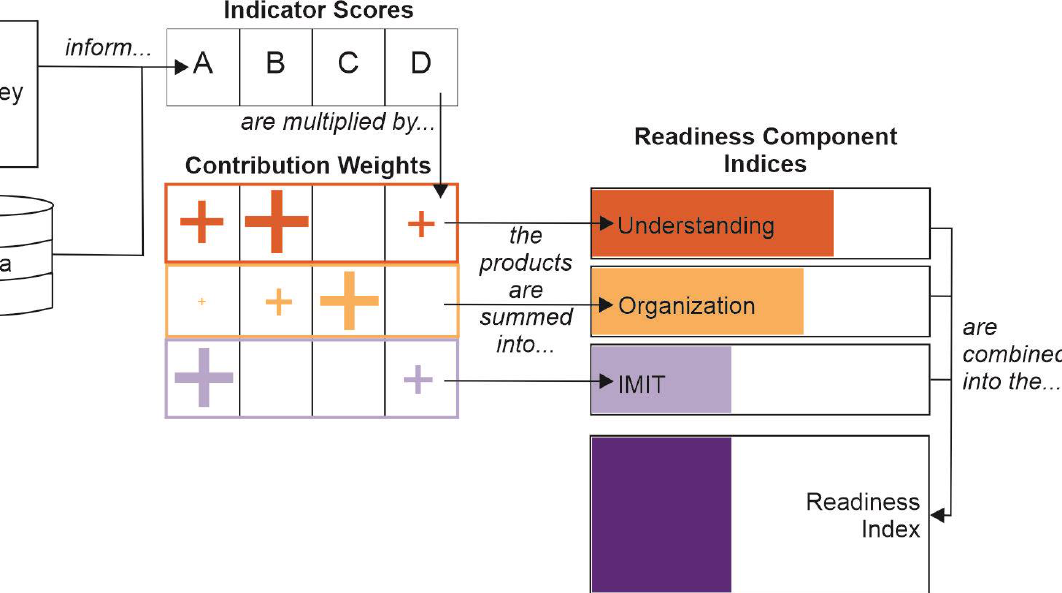
Figure 1. Overview of the formal readiness model. Survey responses, and agency workload and activity data were scored for use as indicators of three components of readiness. The indicators were assigned weights according to their contributions to each component. The products of Indicator Scores and Contribution Weights were summed to produce Readiness Component Indices, each rescaled from 0 to 100. The Readiness Index is derived from the Readiness Component Indices.